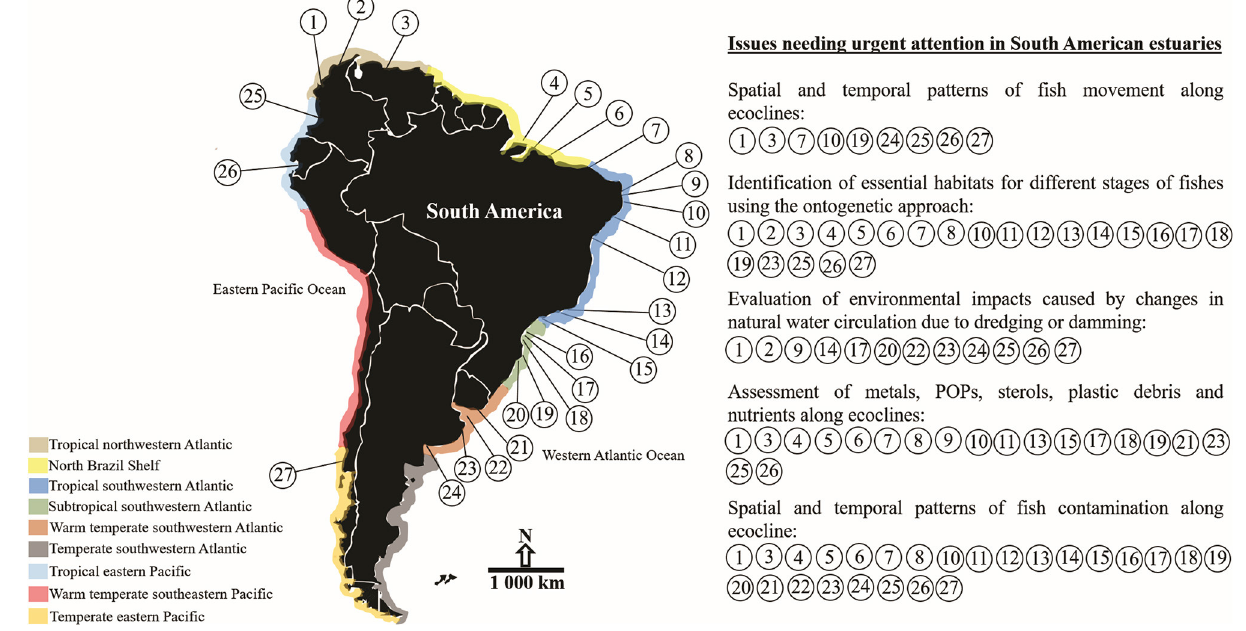
Stellifer rastrifer , Stellifer microps (Sciaenidae), C. spixii ,